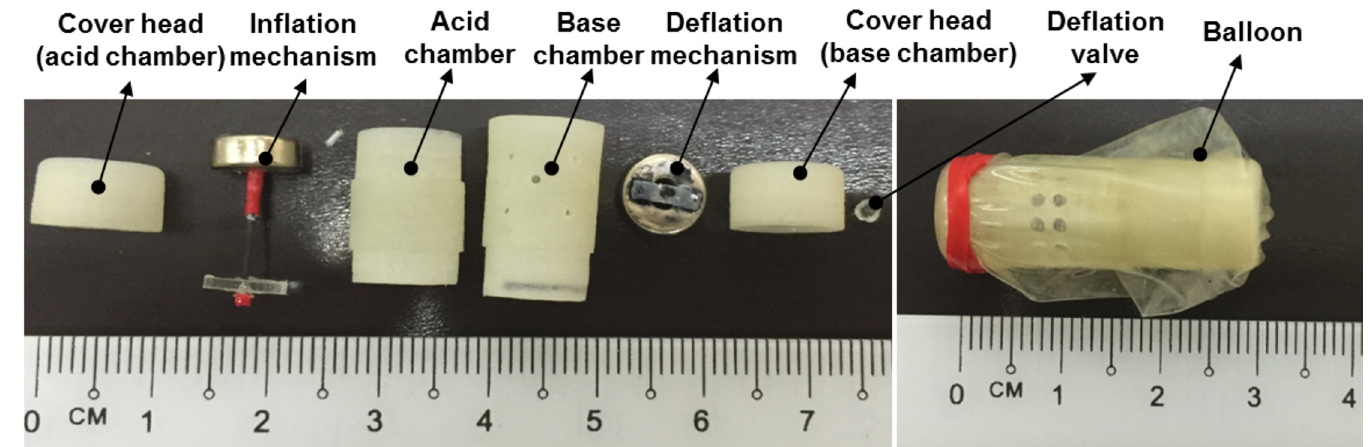
Fig 8. Photos of the MWCE and its outer balloon.